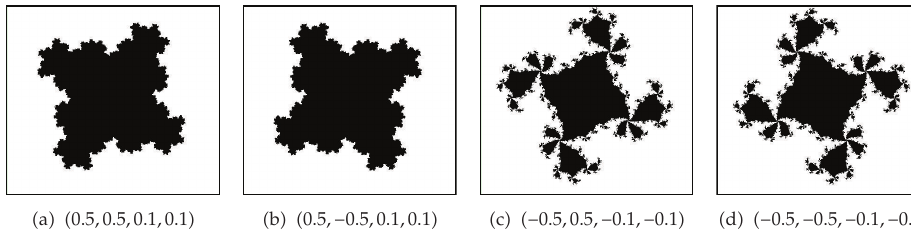
Figure 13: The generalized J sets perturbed by multiplicative noise when α (cid:6)